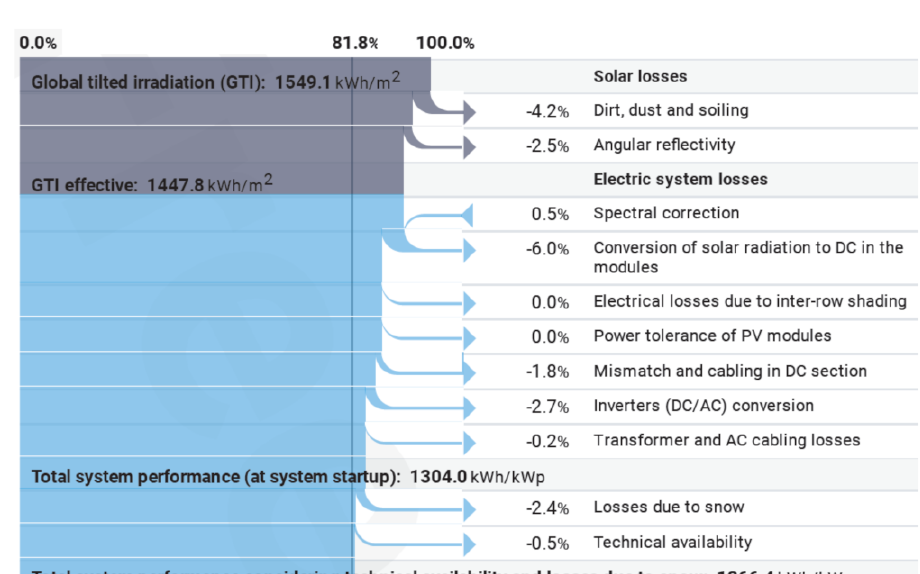
Figure 6. Theoretical losses in a given PV system [24].